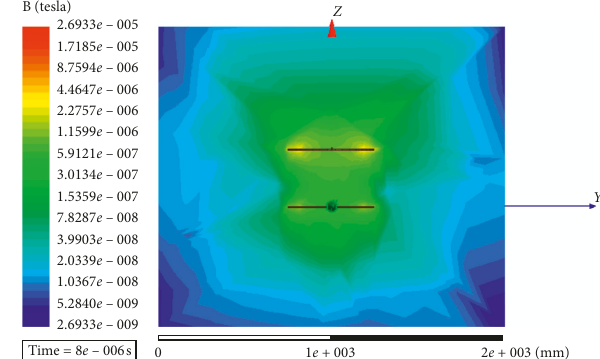
Figure 11: Transient field simulation receiver coil maximum magnetic field.